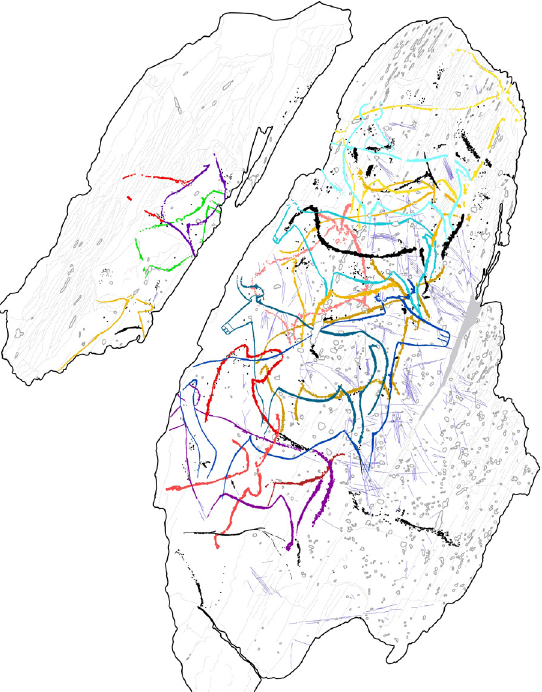
Figure 9. Motifs on Penascosa Rock 3, Côa Valley, Portugal. Tracing: António Martinho Baptista, Fernando Barbosa and Mário Varela Gomes, assisted by Manuel Almeida, João Félix and Cristina Gaspar.